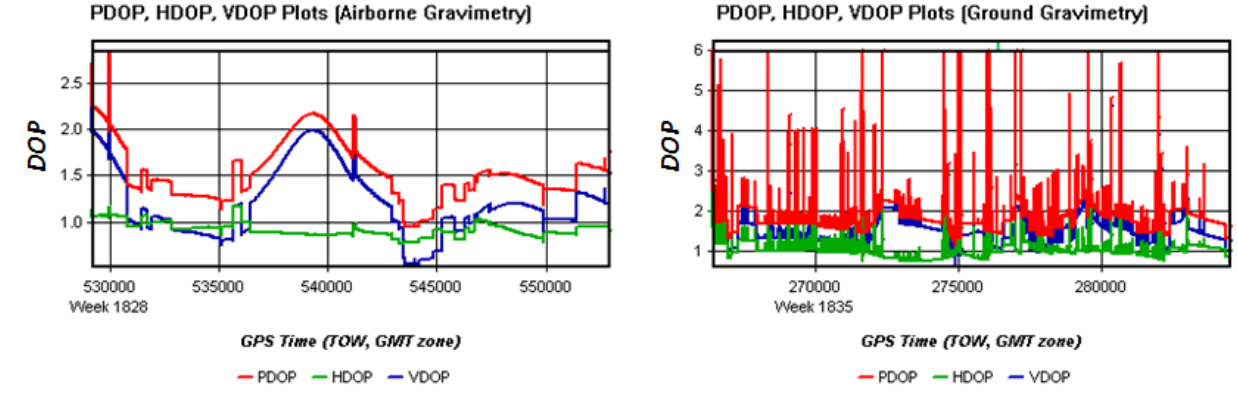
Figure 6. DOP plots of airborne and ground tests. In airborne gravimetry, three DOPs